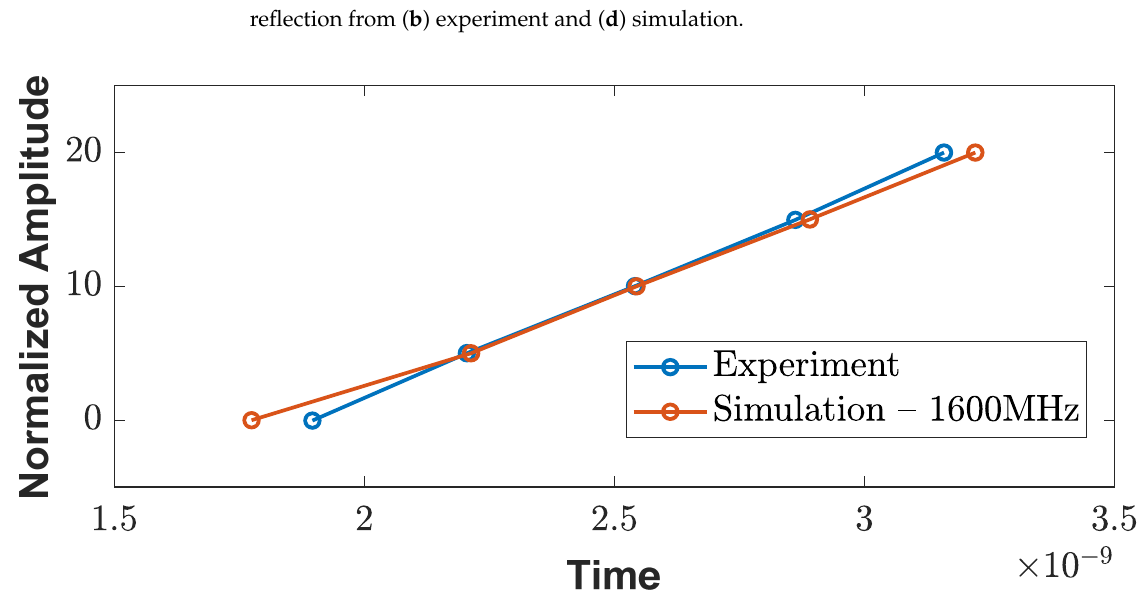
Figure 10. Comparison of slope lines similarity between simulation and experiment.